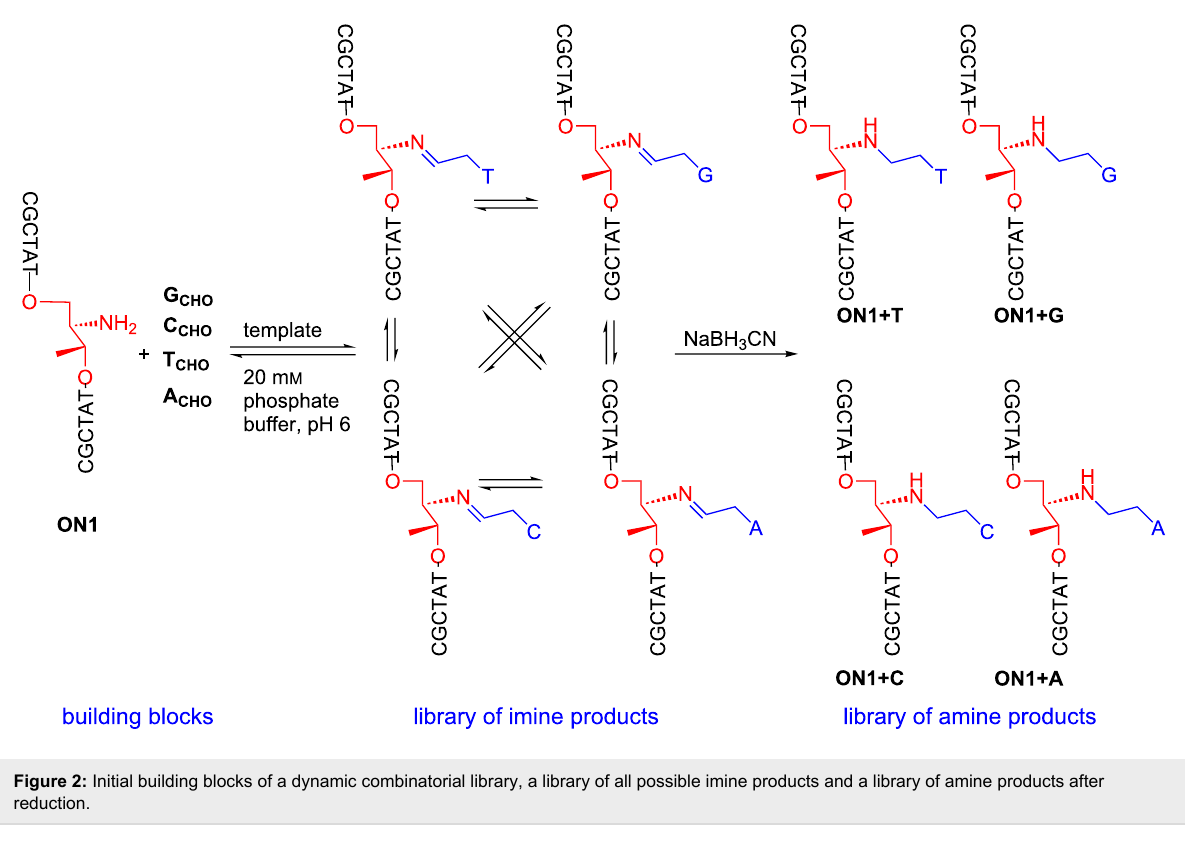
Figure 3: Set of aldehyde-modified nucleobases used in dynamic chemistry assay.